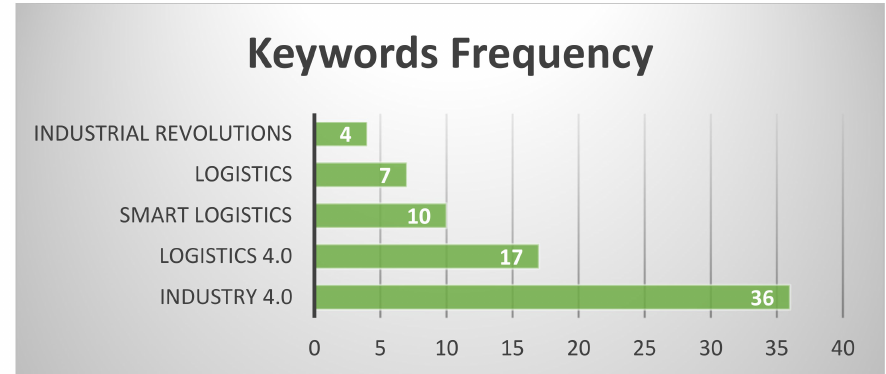
Figure 7. The main keywords